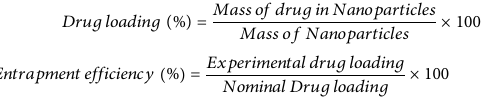
2 illustrates the various general characterization techniques for